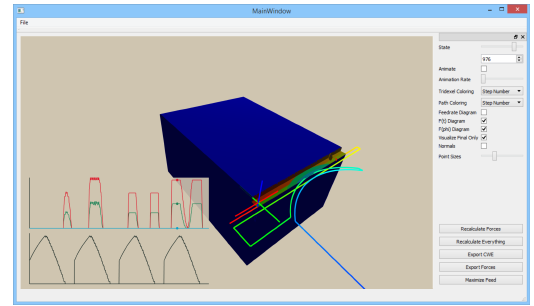
Figure 5. Screenshot of the software on Windows showing the simulation of the later measured